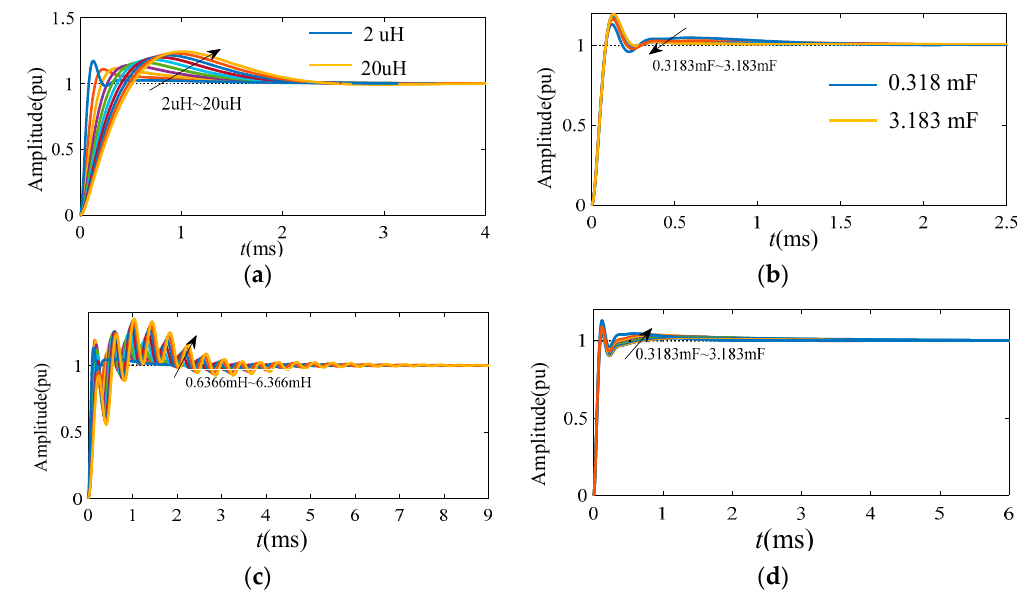
Figure 13. Step response of the filter under different parameters: ( a ) L 1 ; ( b ) C 1 ; ( c ) L 2 , and ( d ) C 2 . Further analysis of the effect of the component parameters on the filter response time and overshoot is illustrated in Figure 14. In this figure, the filter response time, overshoot, and variation trend in different component parameters are presented.